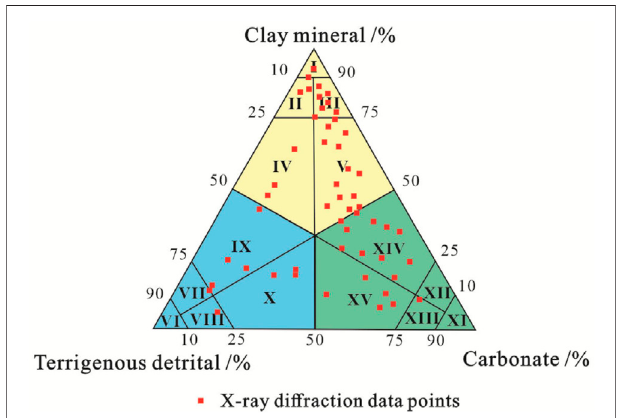
FIGURE 2 | X-ray diffraction data projection points in a triangle chart I. Clay rock; II. Silt-bearing clay rock; III. Lime-/dolomite-bearing clay rock; IV. Silty clay stone; V. Lime/dolomitic clay rock; VI. Siltstone; VII. Clay-bearing siltstone; VIII. Limestone-/dolomite-bearing siltstone; IX. Clay siltstone; X. Lime/dolomitic siltstone; XI. Limestone/dolomite; XII. Clay-bearing limestone/dolomite; XIII. Silt-bearing limestone/dolomite; XIV. Clay limestone/ dolomite; XV. Silty limestone/dolomite.